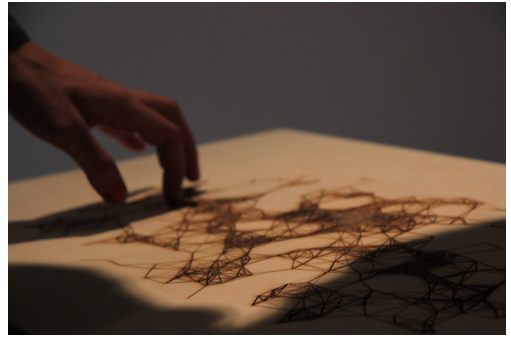
Figure 4. A Tangible